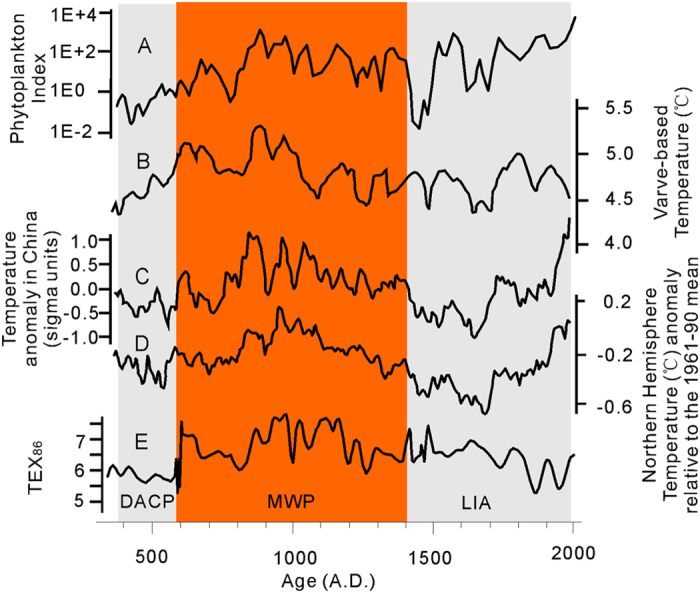
Comparison between the phytoplankton index(A), varve-based paleo-temperature record49 (B), temperature reconstruction of China51 (C) and the northern Hemisphere52 (D), and TEX86 for Kusai Lake over a 1700 year record50 (E). The varve-based paleo-temperature record is absolute temperature. The temperature reconstruction of China is anomaly relative to the average over this period. The temperature reconstruction of the North Hemisphere is anomaly relative to the average of 1961–1990. The TEX86 record is calculated using the composition of archaeal isoprenoidal glycerol dialkyl glycerol tetraethers (GDGTs)50. DACP, MWP and LIA refer to the Dark Age Cold Period, the Medieval Warm Period, and Little Ice Age, respectively49.